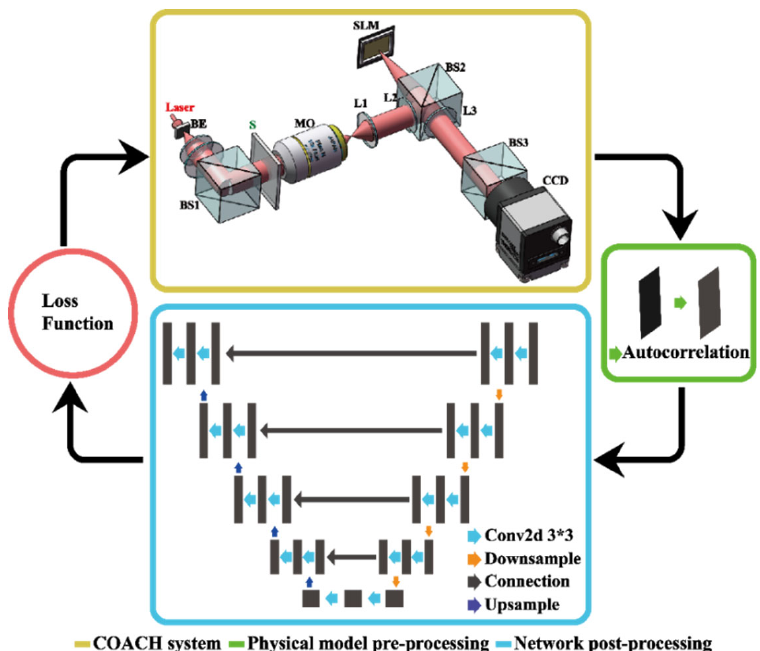
Figure 5. Schematic of the physics ‐ informed deep learning method.